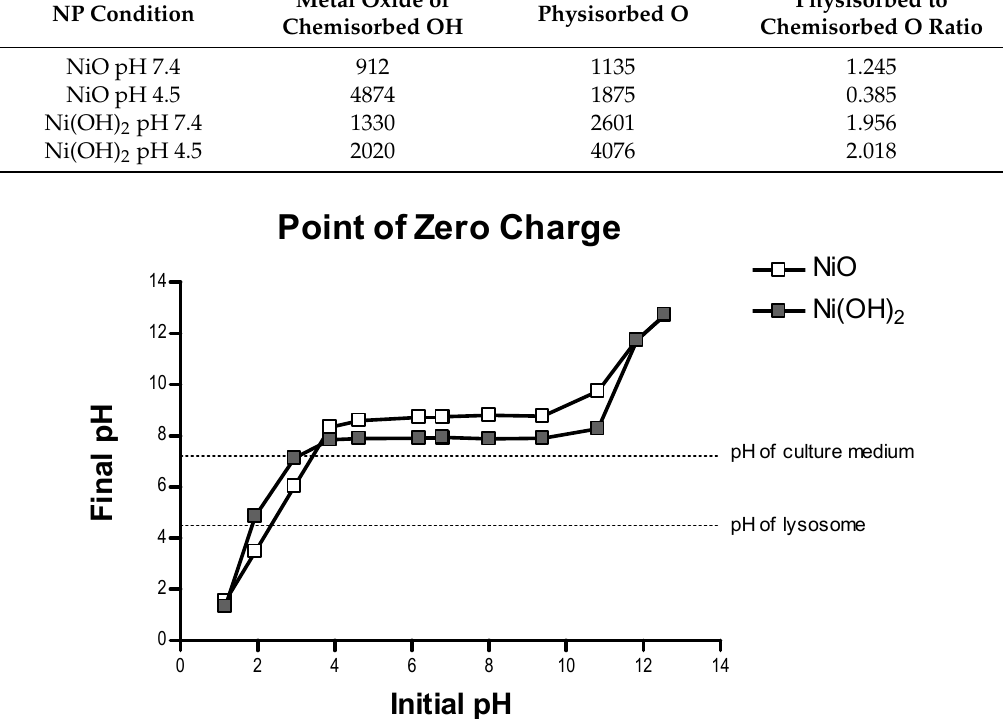
Figure 2. Point of zero charge (PZC) analysis of NiO and Ni(OH) 2 . Results indicate that the PZCs of NiO and Ni(OH) 2 are 8.7 pH and 7.9 pH. Table 2. Relative number of binding sites from integrated X-ray photoelectron spectroscopy (XPS) O 1s peak areas.